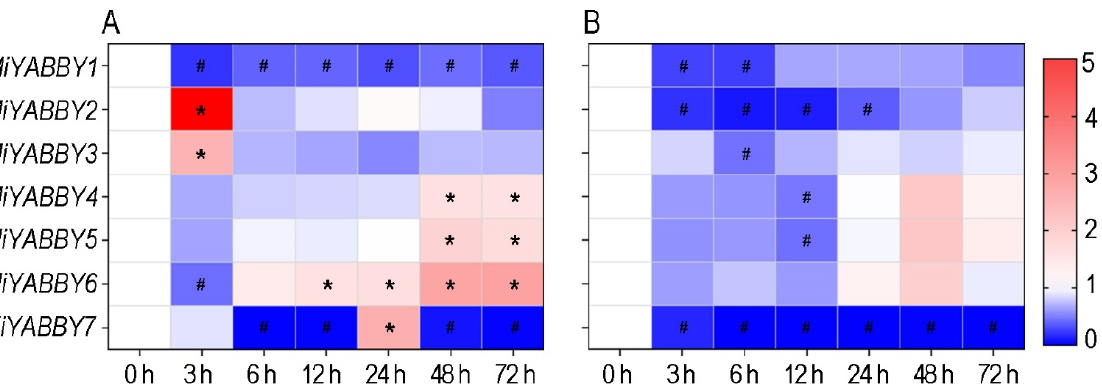
Figure 4. Relative expression analysis of the MiYABBY gene family that were infected with different pathogens in mango. ( A ) shows the results of Cg infection, and ( B ) shows the results of Xcm infection. The calculation method was 2 −∆∆ CT , and ‘*’ means the value exceeds 1.5, whereas ‘#’ means that the value is below 0.5.